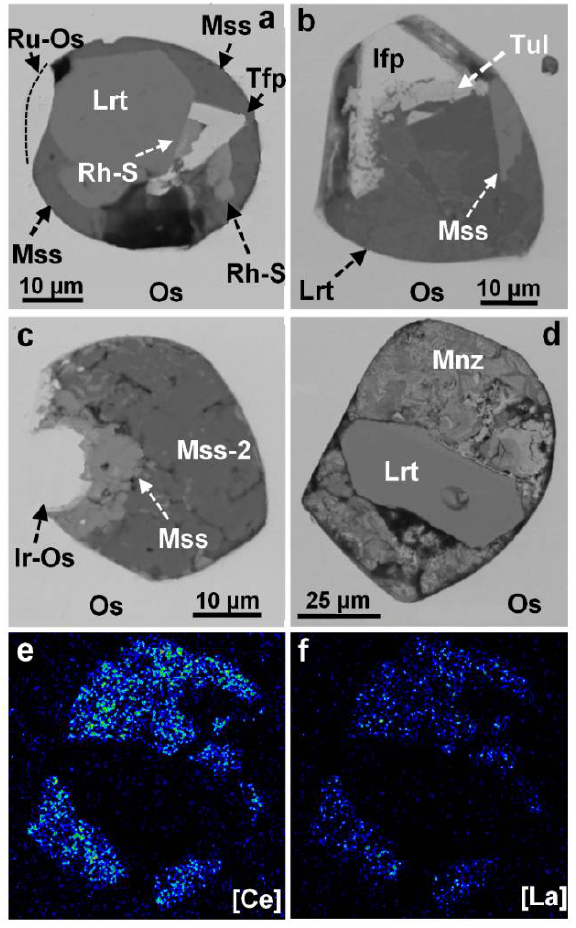
Figure 3. ( a ) BSE image displaying a multiphase inclusion enclosed by a placer grain of an Os-dominant alloy (Os) [Os 35.5 Ru 32.7 Ir 31.8 ] from the Sisim placer zone. It consists of a subhedral crystal of nearly end-member laurite (Lrt) [Ru 0.99 S 2.01 ], a phase of tetraferroplatinum (Tfp) [(Pt 0.93 Pd 0.06 ) Σ0.99 (Fe 0.58 Cu 0.24 Ni 0.19 ) Σ1.01 ], a monosulfide-type phase (Mss) having the composition [(Ni 0.55 Fe 0.33 Rh 0.10 ) Σ0.99 S 1.01 ], and a pentlandite-type phase (Rh–S); ideally (Rh,Ni,Cu) 9 S 8 [(Rh 6.67–6.72 Ni 1.70–1.76 Cu 0.54–0.58 Fe 0.15 ) Σ9.1–9.2 S 7.8–7.9 ]. A Ru-dominant alloy (Ru–Os) [Ru 41.0 Ir 32.4 Os 19.7 Rh 4.1 Fe 1.6 Pt 1.2 ] occurs as a narrow rim, forming part of this inclusion. ( b ) BSE image displaying a composite inclusion, hosted by an Os-dominant alloy [Os 53.0 Ir 30.6 Ru 16.4 ], which is associated with isoferroplatinum (Ifp) [Pt 2.95 (Fe 0.98 Ni 0.07 )], rimmed partly by a tulameenite-type phase (Tul; Pd-bearing) [(Pt 1.60 Pd 0.56 )Fe 0.95 (Cu 0.83 Ni 0.06 )]. Also present are a monosulfide phase [Ni 0.23 Fe 0.23 Ir 0.16 Rh 0.13 Cu 0.12 Ru 0.03 ) Σ0.90 S 1.10 ] and a laurite-type phase (Lrt) [(Ru,Fe,Ni,Rh)S 2–x ], which likely represents a solid solution toward pyrite and vaesite [(Ru 0.49 Fe 0.26 Ni 0.24 Rh 0.11 Cu 0.07 Ir 0.04 ) Σ1.21 S 1.80 ]. ( c ) BSE image of a core-like zone of Ir-dominant alloy (Ir–Os) [Ir 62.3 Os 26.4 Ru 11.2 ], which is surrounded by a monosulfide-type phase (Mss) [(Ni 0.28 Fe 0.21 Ir 0.17 Rh 0.12 Cu 0.11 Pt 0.03 ) Σ0.92 S 1.08 ]. The second phase of the latter type (Mss-2) has the following composition: [(Ni 0.52 Fe 0.39 Rh 0.10 ) Σ1.01 S 1.00 ]. This inclusion is enclosed within a grain of Os-dominant alloy [Os 46.5 Ir 41.0 Ru 12.6 ]. ( d ) BSE image of a subhedral crystal of zoned laurite (Lrt) occurring at the center of inclusion with the composition (Ru 0.89 Ir 0.05 Os 0.04 ) Σ0.98 S 2.02 in the central phase rimmed by a narrow zone rich in Ir [(Ru 0.74 Ir 0.16 Rh 0.07 ) Σ0.97 S 2.03 ]. An aggregate of microcrystalline grains of a colloform rare-earth element (REE) phosphate that precipitated around the laurite core corresponds to monazite-(Ce) (Mnz). Inclusion hosted by a grain of Os-dominant alloy (Os) [Os 43.3 Ir 42.2 Ru 14.6 ]. ( e , f ) X-ray maps show the distribution of Ce (Figure 3e) and La (3f) in the grain of the REE phase of monazite-(Ce) shown in Figure 3d.